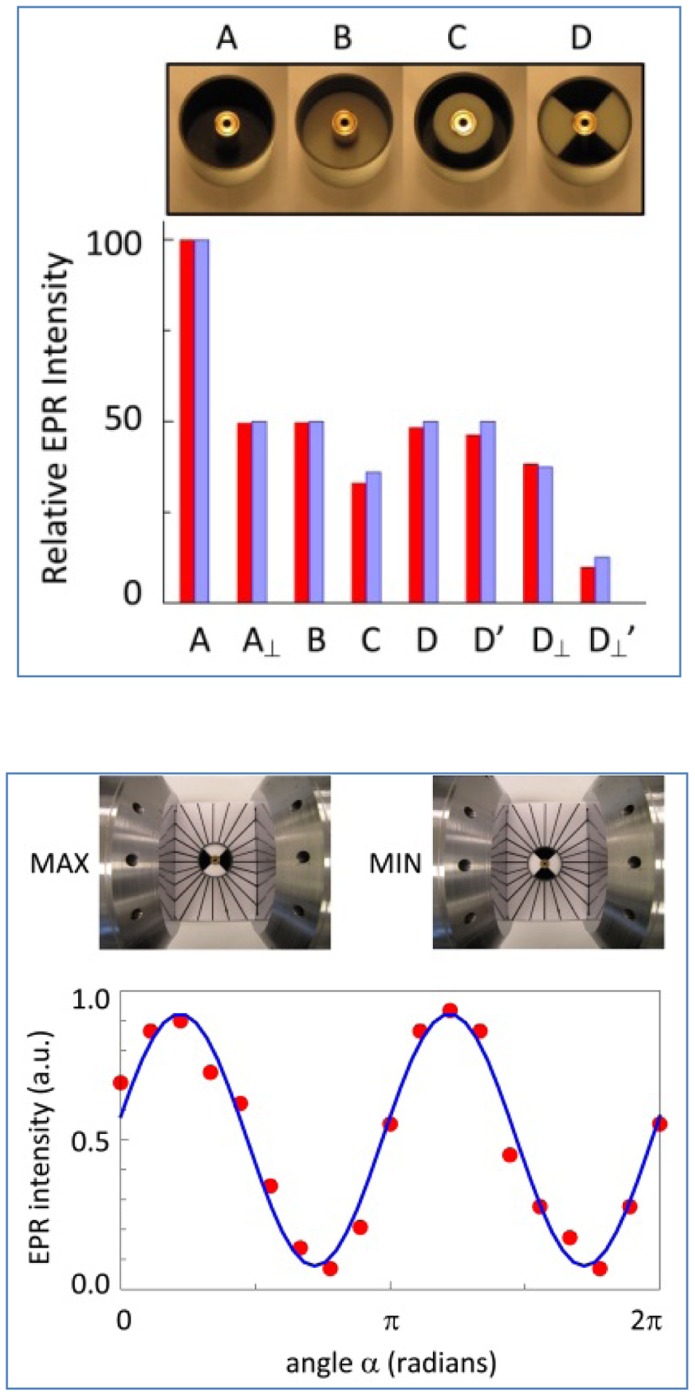
Signal intensity as afunction of TEM versus B orientation.Bar A is the Mn(II) reference signal from the 42 mm standard cell. Red bars are measured intensities and blue bars are theory-predicted. Bars E, F, and G are from 82 mm Al cells with inner diameter of the outer conductor 8, 6, and 4 mm, respectively. Bars G’ and G⊥ are for the 4 mm i.d. cell with TEM axis at 45 and 90 degrees versus B. The lower panel shows a full 360 degree rotation experiment for the 4 mm i.d. cell with intensity data fitted to eqn (30).